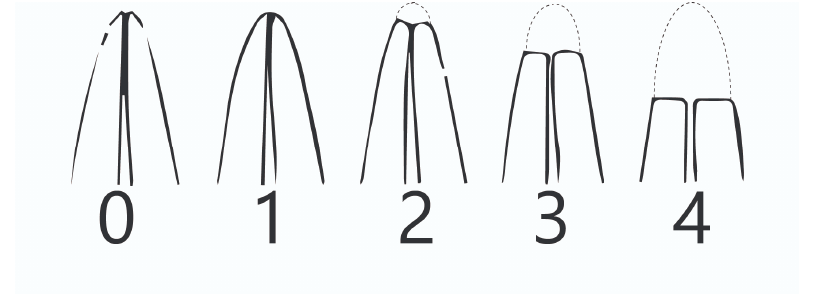
Figure 6. External apical root resorption classification (Levander and Malmgren grading 0–4).